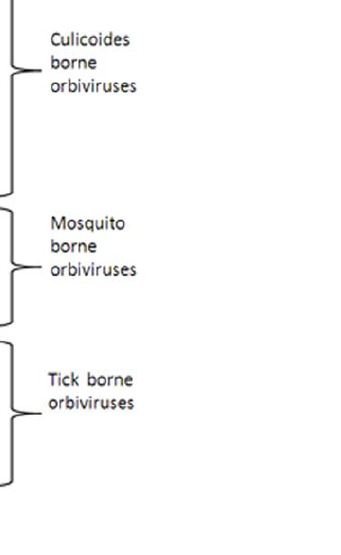
Figure 4. Neighbour-joining tree showing the relationships between amino acid sequences of polymerase protein of different orbiviruses. The UMAV isolate characterised in this study is shown in red font. Full names of virus isolates and accession numbers of polymerase sequences used for comparative analysis are listed in Table S2. ‘(E)’ and ‘(W)’ - indicate eastern and western strains, respectively.